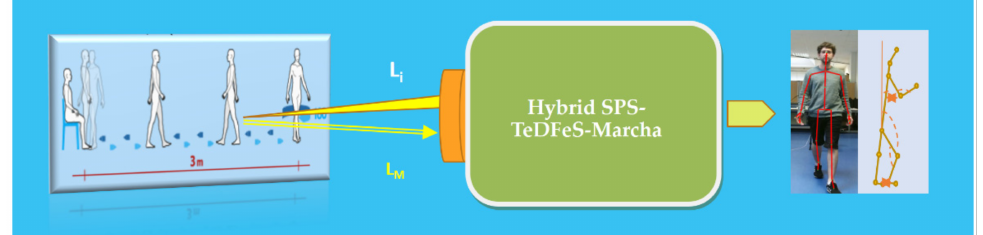
Figure 15. Schematic illustration of contactless hybrid SPS based on structured Light, flight time, and a smart chair. The patient is eliminated during the test with structured infrared Light (Li). The returning Light from the patient, LM, is then detected and adequately processed. This is collected simultaneously with the information from a smart chair, combined “harmoniously” in the control and processing unit of the SPS. The results emerge in real-time, are stored and collected in a report, and can be viewed as the patient executes an adequately designed exercise. Made by the author based on material courtesy of the Photonic Engineering Group of